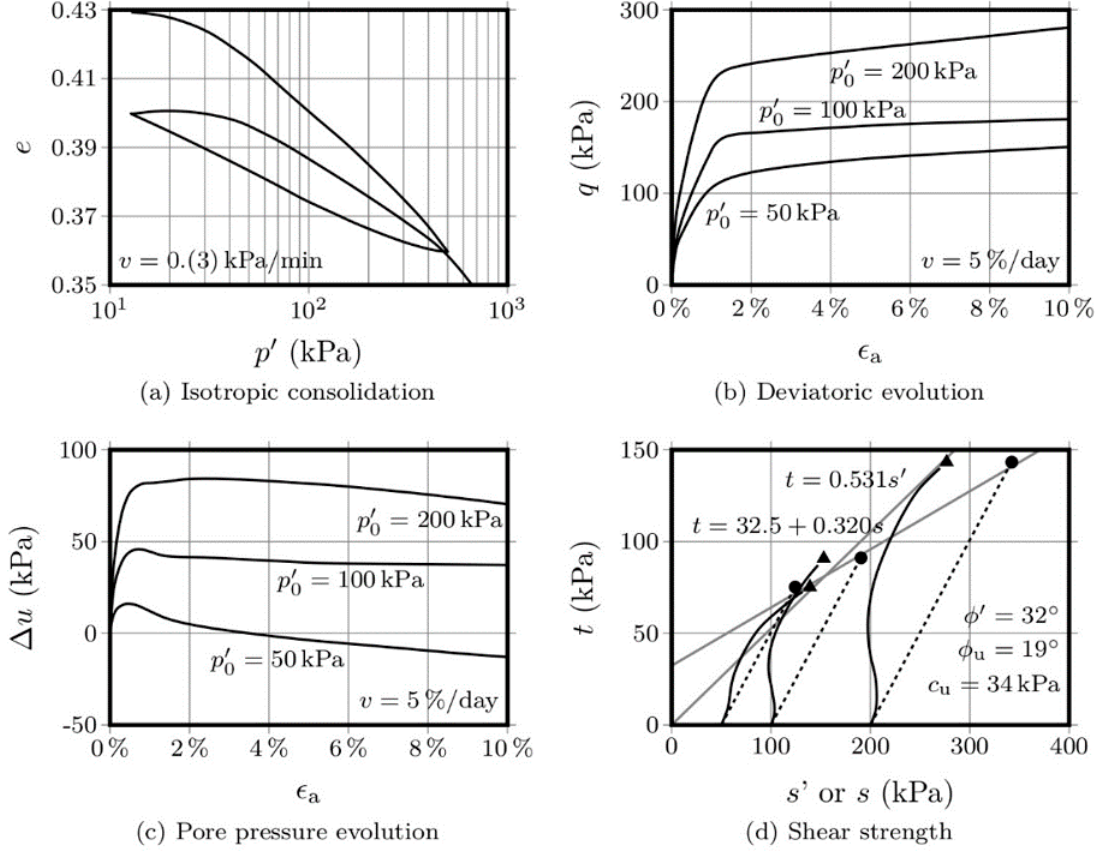
Figure2. Consolidatedundrainedtriaxialtestsperformedontheoriginalsoil(withoutartificialcementation). Figure 2. Consolidated undrained triaxial tests performed on the original soil (without artificial cementation).